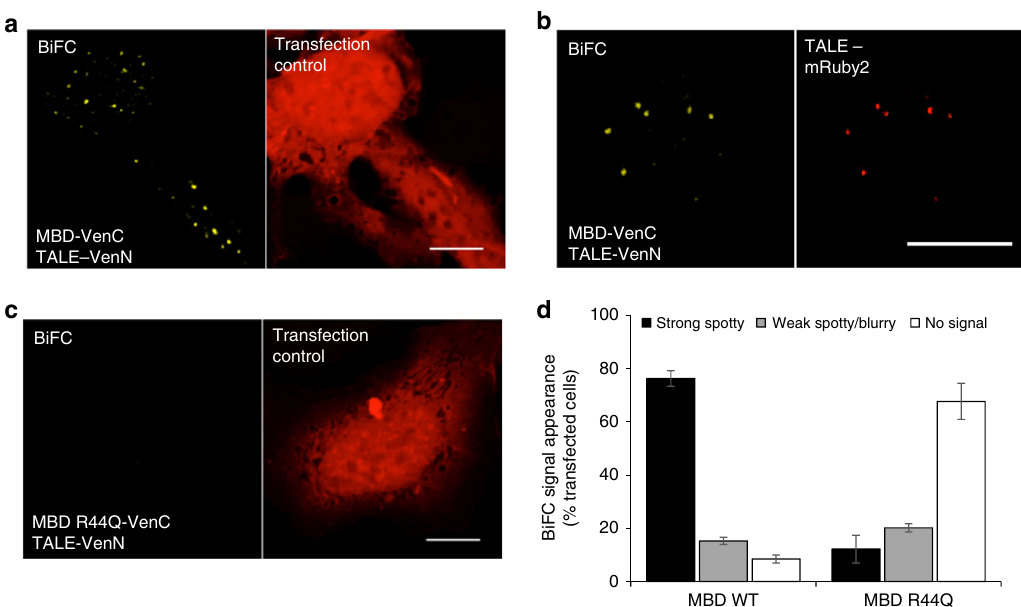
Fig. 3 Development and validation of the BiAD sensor 2. a Representative fl uorescence microscopy image showing that BiAD sensor 2 gives rise to distinct BiFC signals in HEK293 cells. NLS-mRuby2 was used as transfection control. b Co-localization of the BiFC signal with the TALE protein fused to mRuby2 documents the high-DNA speci fi city of the BiAD sensor. c Loss of the BiFC signal when the R44Q MBD variant was used as a detector module con fi rms the 5mC speci fi city of the BiAD sensor. d Quanti fi cation of the experiments representatively shown in panels a – c . The error bars represent the s.e.m. for two biological repeats (for details cf. Methods and Supplementary Tables 2, 6, and 7). All cells were fi xed at 48 h after transfection. Scale bar for all images is 10 µ